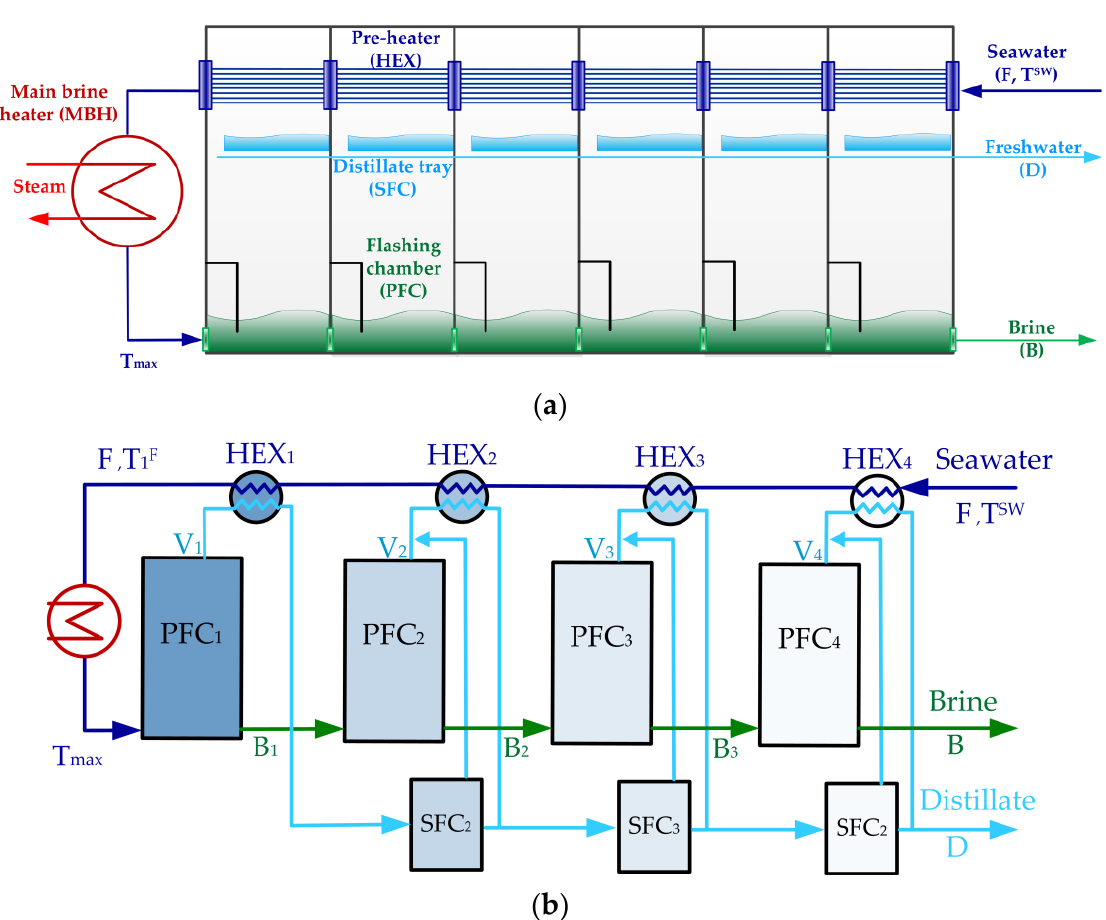
Figure 2. ( a ) Schematic of a MSF desalination system; ( b ) representative system for mathematical modeling.